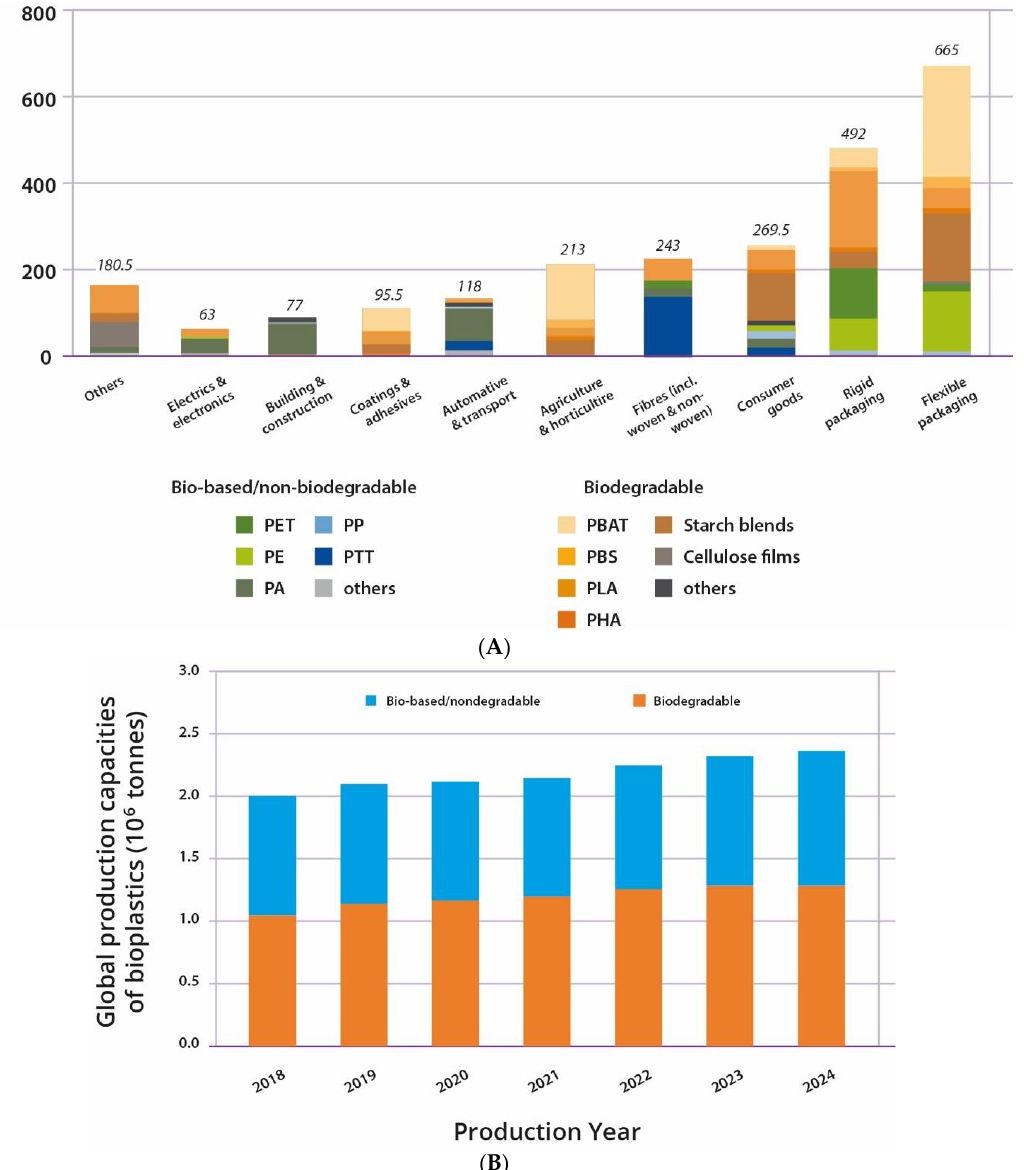
Figure 22. Global production capacities of bioplastics 2021 (by market segment) ( A ) and growth of bioplastic production in recent years ( B ). Adapted from European Bioplastics, “Bioplastics market data”, https://www.european-bioplastics.org/market/ (accessed on 29 December 2022)